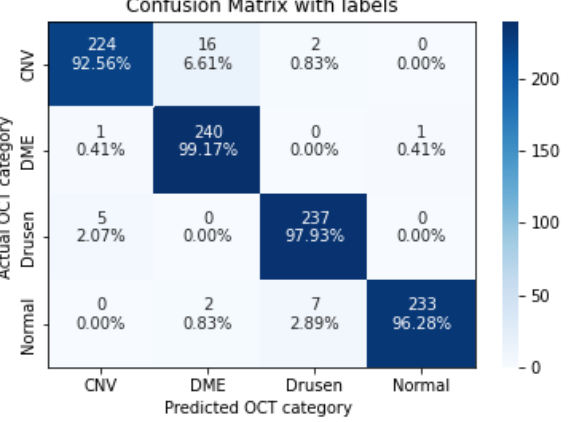
Figure 7. The confusion matrix of 5 layers model, with numbers and